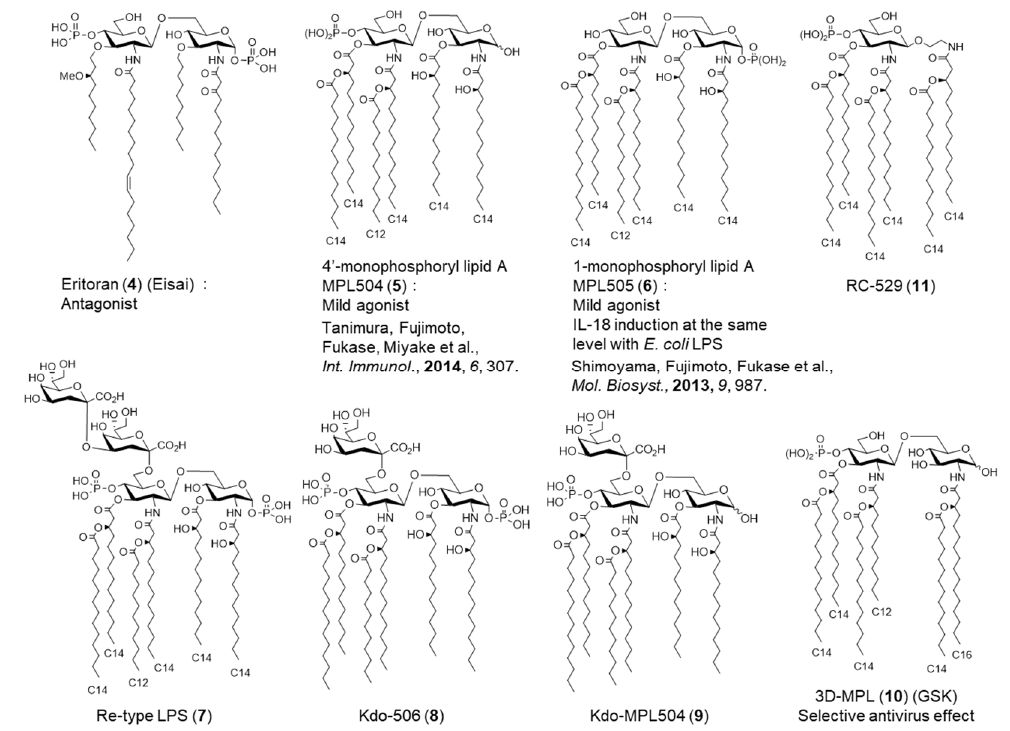
Figure 6. Chemical structures of various lipid As and lipid A analogs.